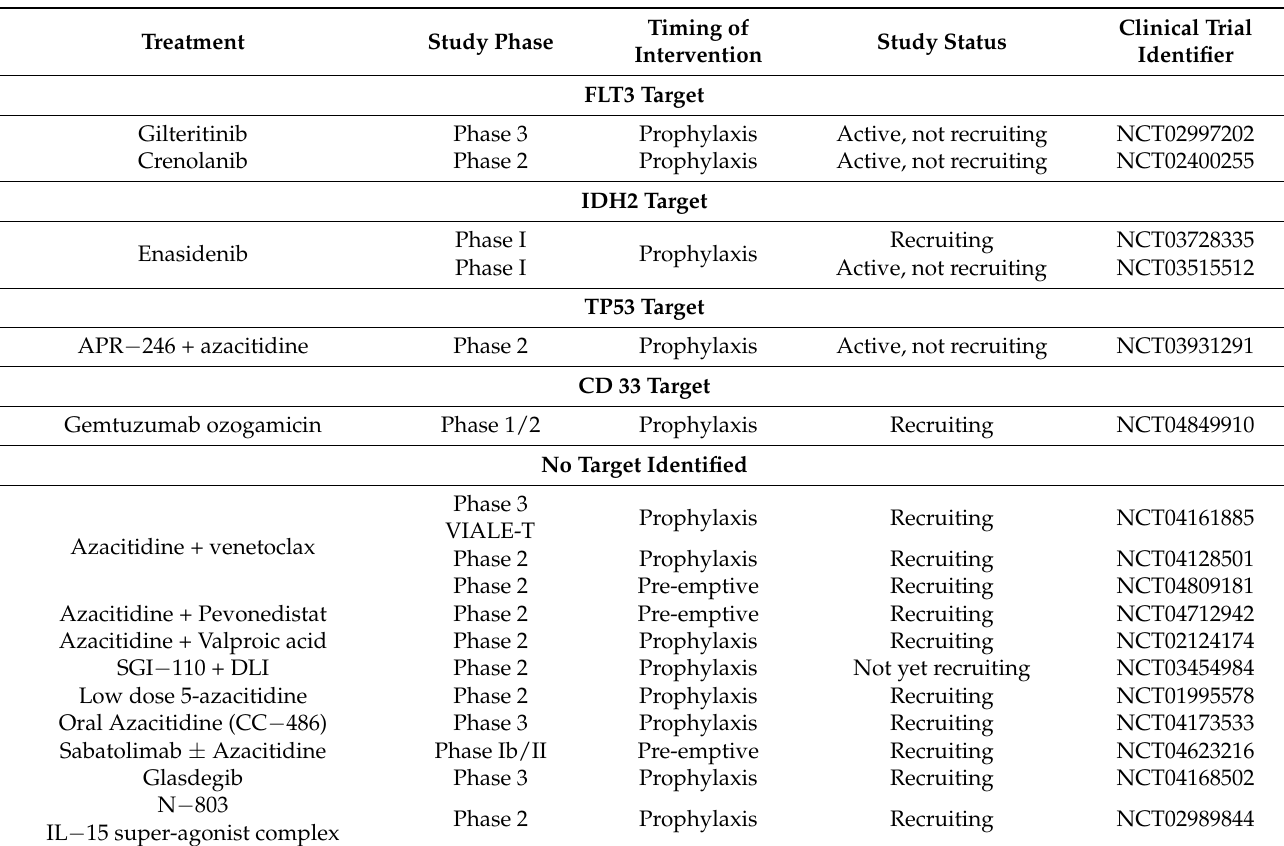
Table 1. Selected ongoing trials evaluating post-transplant maintenance treatments in acute myeloid